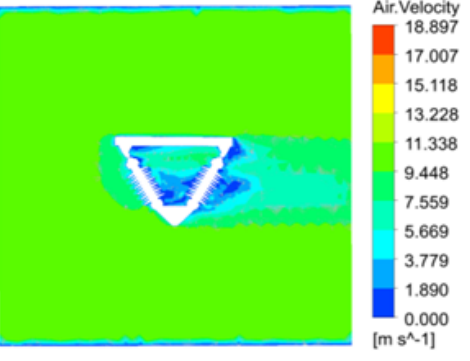
Figure 13. Cloud map of the plane velocity distribution under the wind speed of 10 m/s.